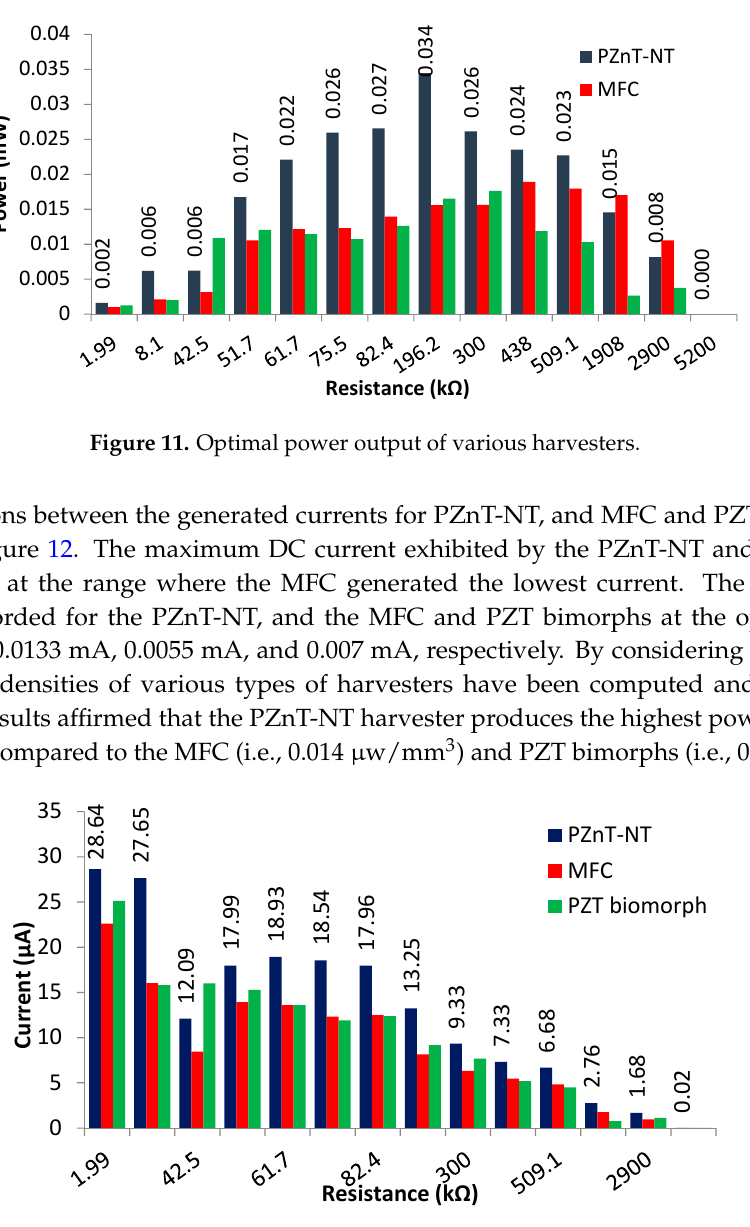
Figure 13. Power density of piezoelectric devices versus the resistance.